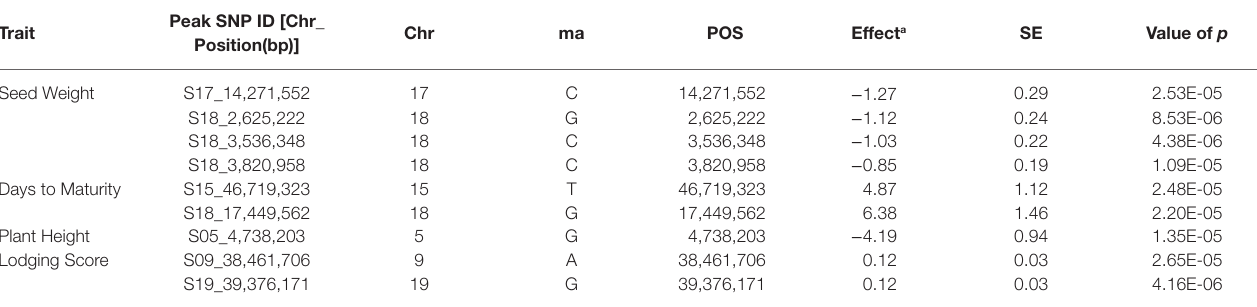
TABLE 2 | Significant associated genomic regions for the agronomic traits: 100 seed weight, days to maturity, plant height, and lodging score detected in combined- year GWAS analysis.